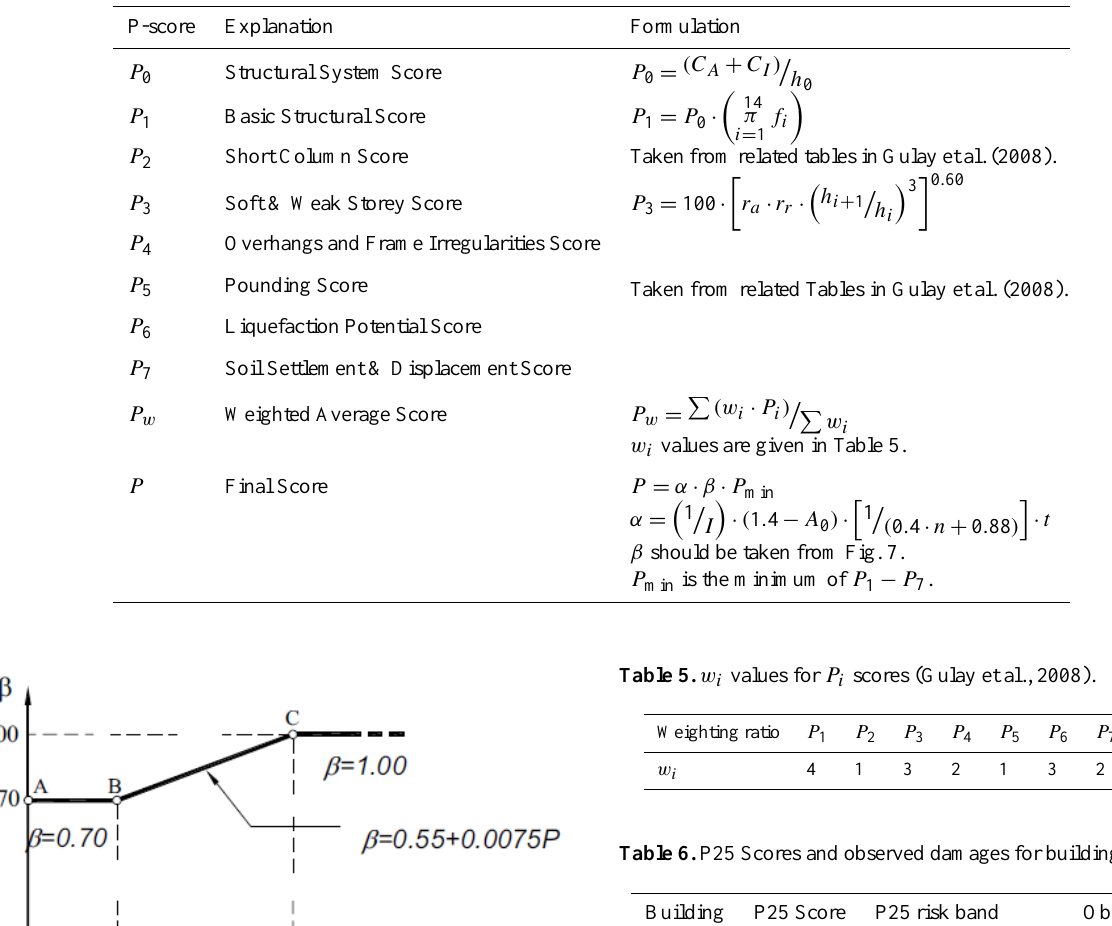
Table 4. Calculation of P-scores.